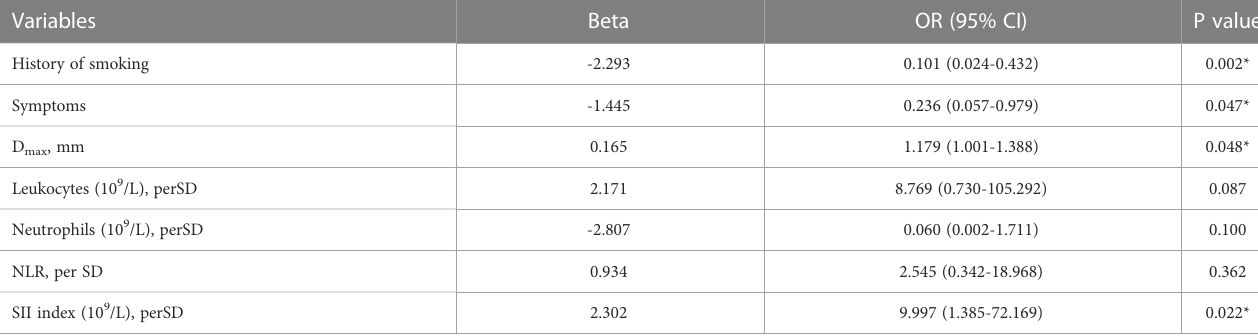
TABLE 2 Multivariable analysis for predictors associated with